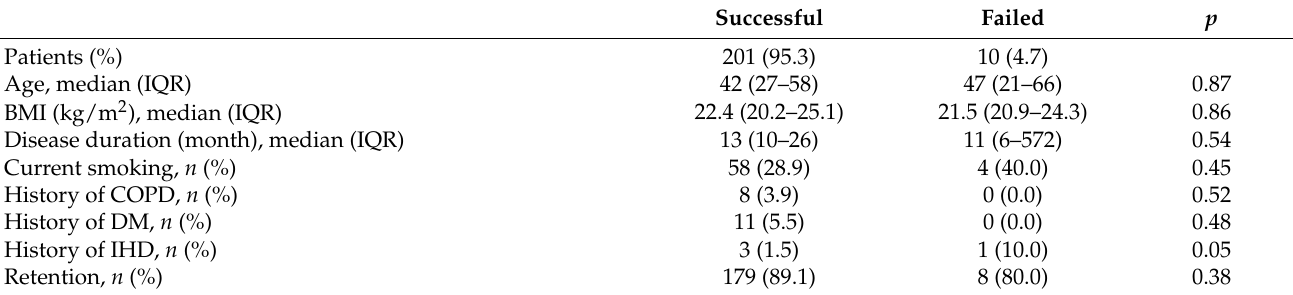
Table 4. The association of surgical outcomes with clinical